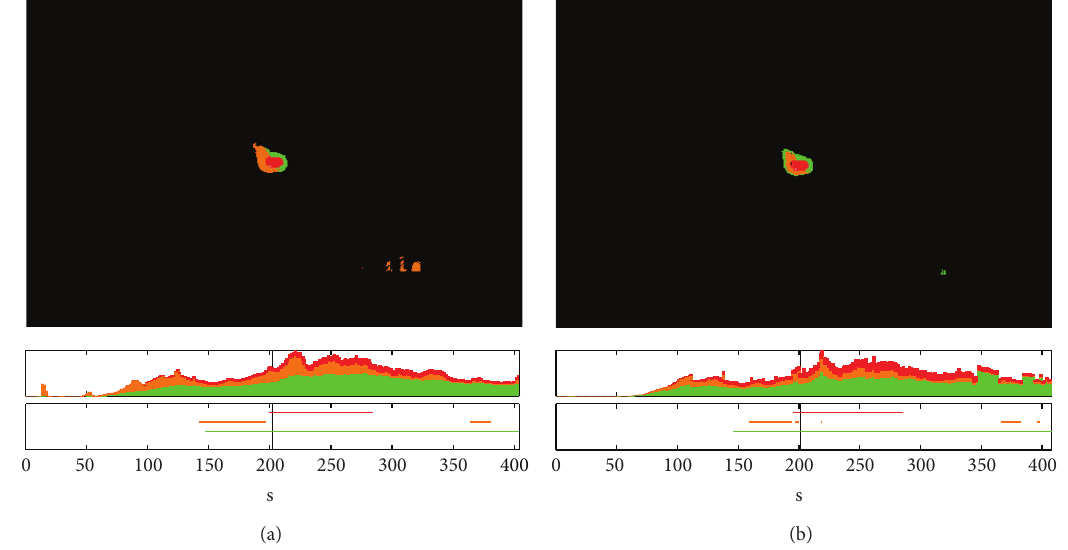
Figure 8: Fire alarm evolution for a fixed PFA with independent detectors (a) and fused detectors (b) in Font Roja.